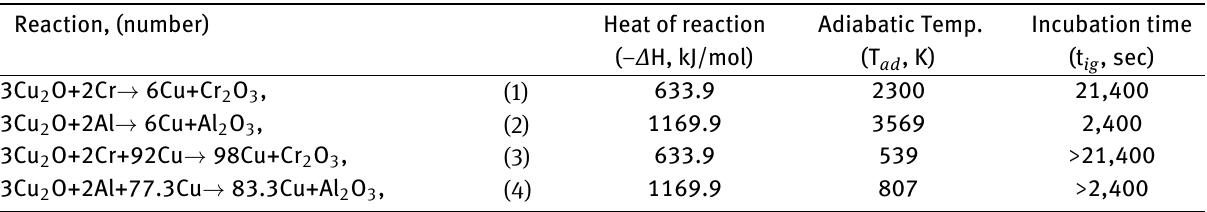
Table 1: The released heat of reaction ( − ∆ H) and the calculated adiabatic temperature (T ad ) and incubation time (t ig ) to ignite of correspond- ing displacement reactions.